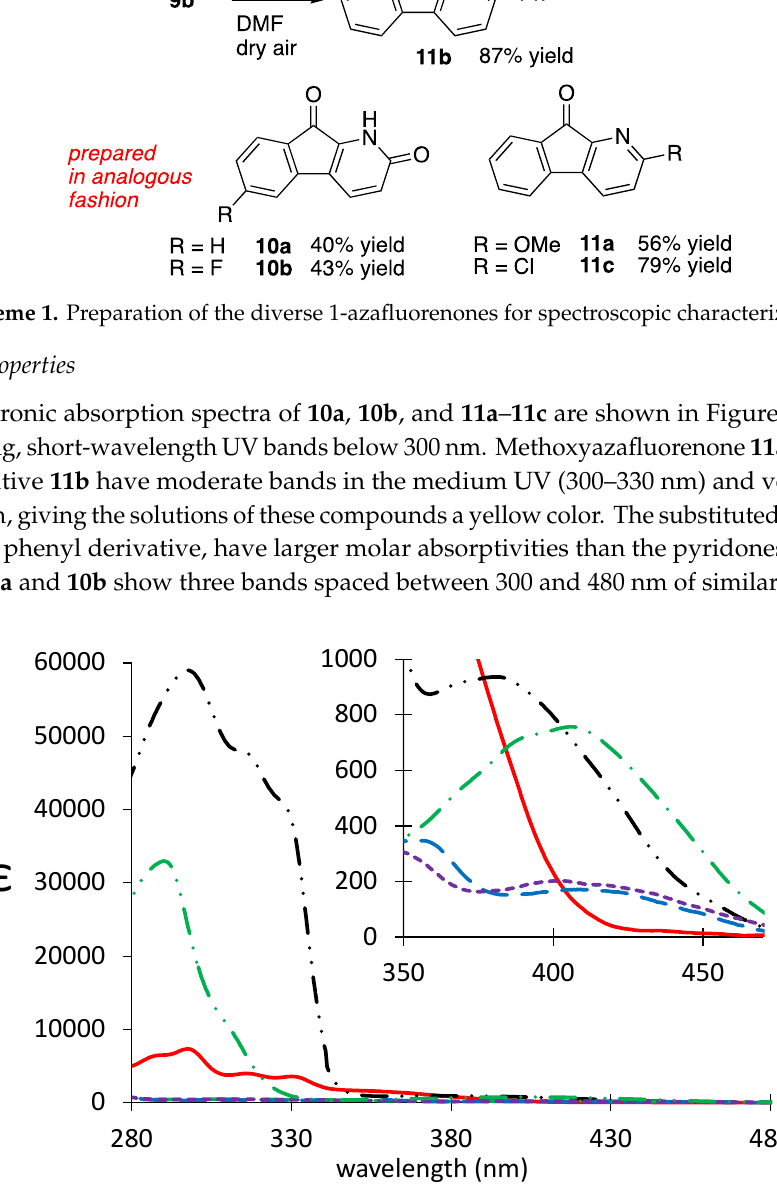
Figure 3. Normalized fluorescence of pyridinones 10a and 10b in ethanol ( 10a (H), — — ; 10b (F), – – – ).